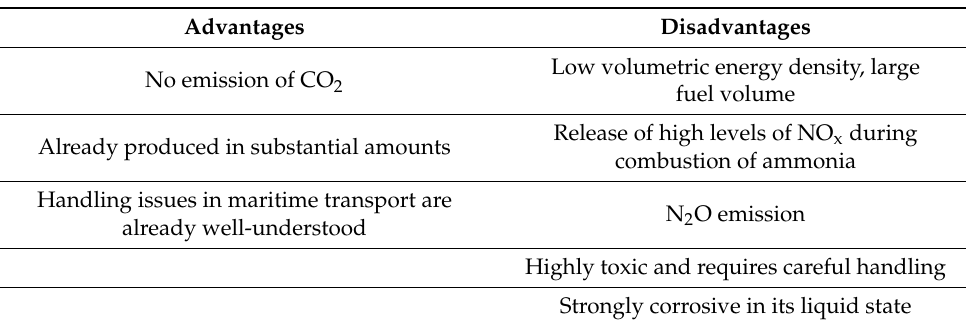
Table 5. An overview of the advantages and disadvantages of ammonia as an alternative fuel for the shipping sector [30,61–63,66,73].